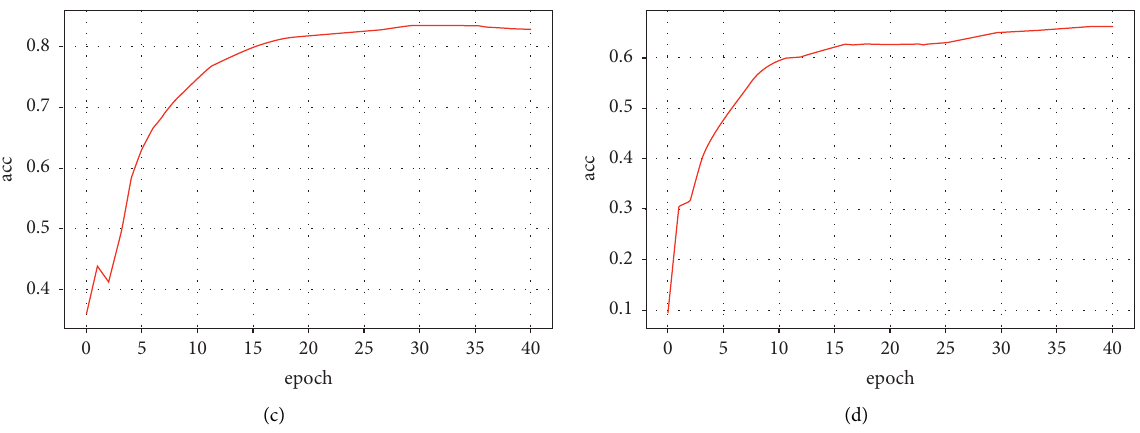
Figure 6: The training process of the LREE as an EEG feature. Table 4: Test set classification results. Sample